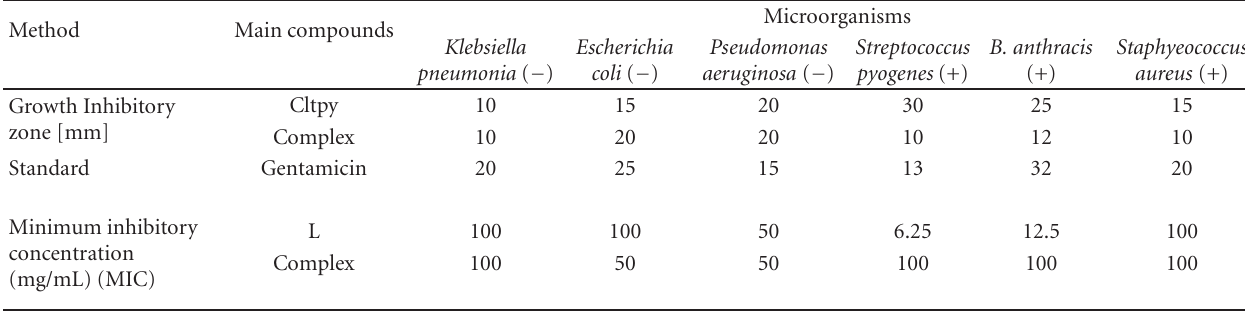
Table 4: Antibacterial activities (zone of growth inhibition and minimal inhibitory concentrations) of Cltpy ligand and Cd (II) complex and gentamicin (as a standard